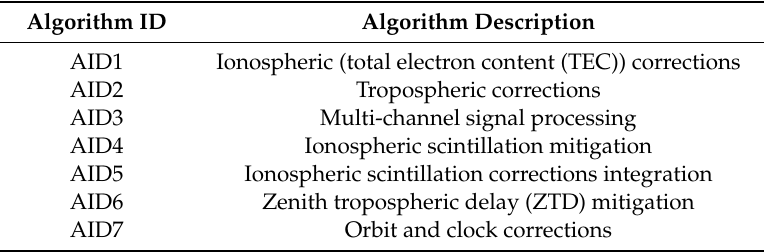
Table 1. TREASURE innovative algorithms .